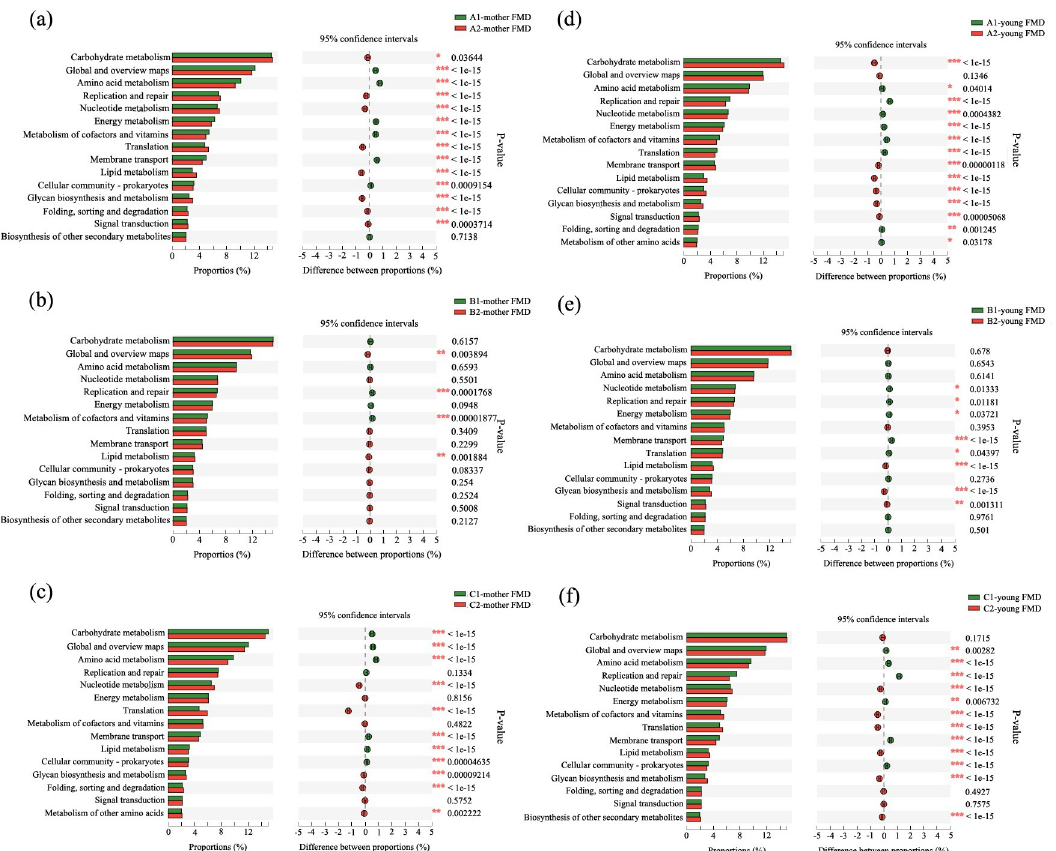
Fig 3. Comparison of functional differences before and after separation of female (a-c) and infant FMD (d-f) based on the KEGG database at different separation times (a, d: 80 days; b, e: 90 days; c, f: 100 days).